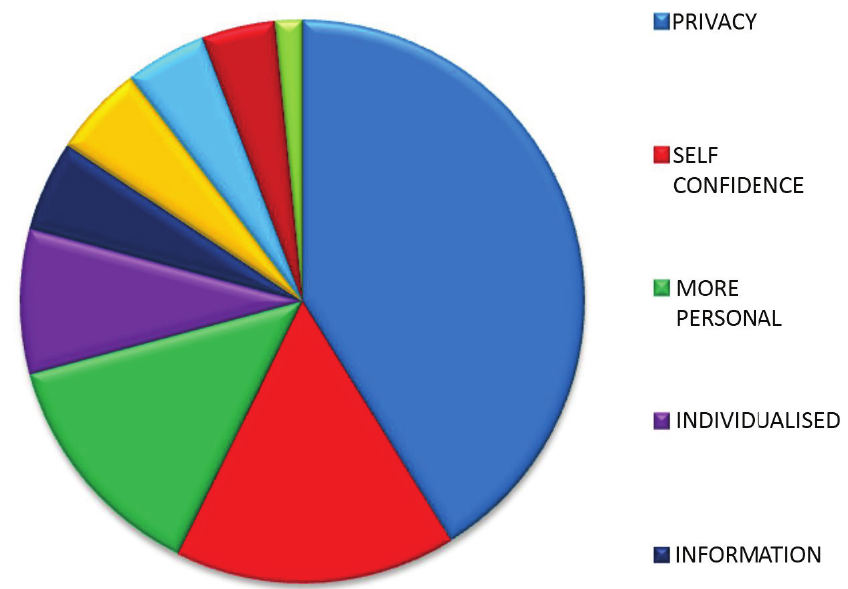
Figure 1. Proportions of respondents giving various reasons for preferring individual appointments.